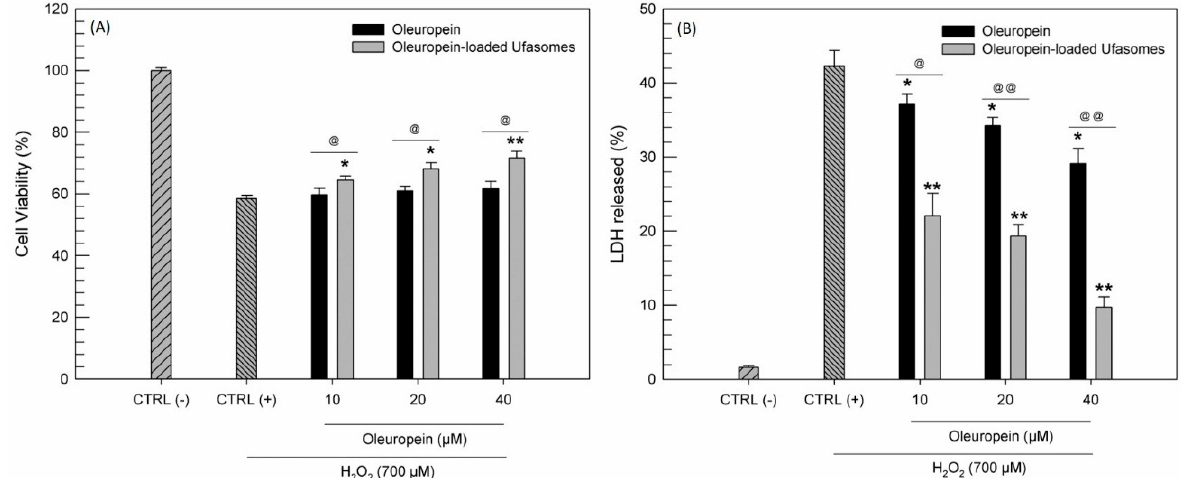
Figure 10. Antioxidant activity evaluation expressed as cell viability ( A ) and lactic hydrogenase (LDH) released ( B ). The tests were carried out on CaCo-2 treated with increased oleuropein concentrations, in free form and as active substance loaded ufasomes (Formulation A100), for 24 h and then with H 2 O 2 (700 µM) for 1 h. The results are the average of three independent experiments ± standard deviation. * p < 0.05 and ** p < 0.001 versus H 2 O 2 ; @ p < 0.05 and @@ p < 0.001 oleuropein-loaded ufasomes versus the same concentration of free oleuropein.